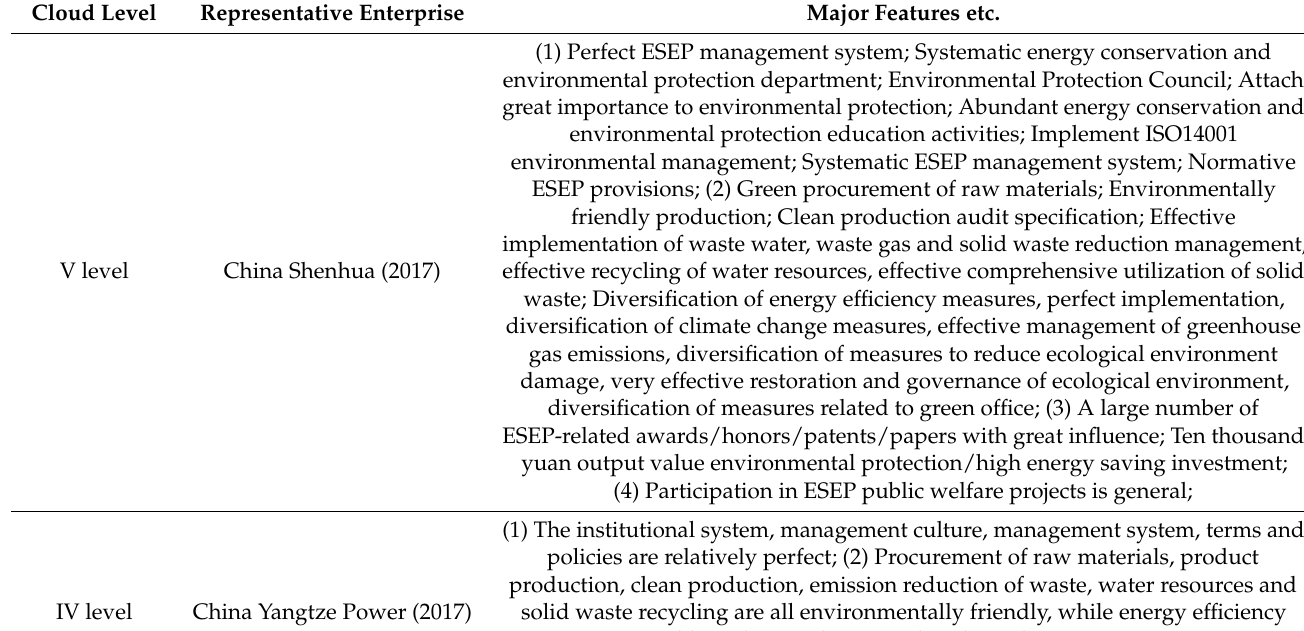
Table 6. Analysis of representative companies at each